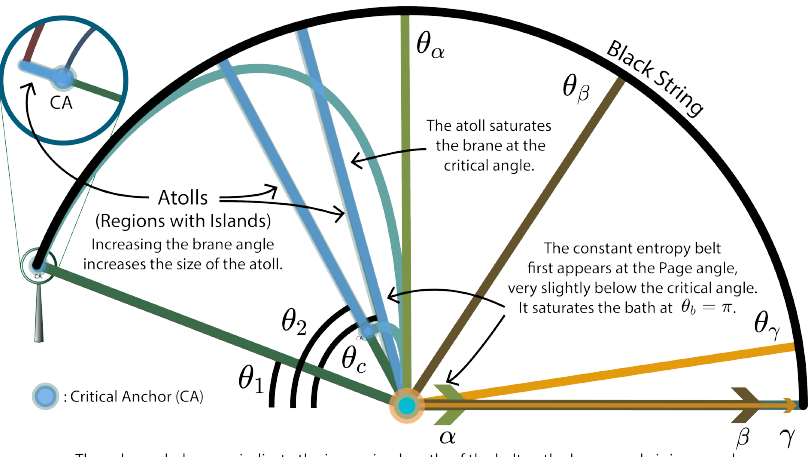
Figure 12 . When an RT surface anchors within the constant entropy belt on the bath, the island surfaces are dominant on the initial time slice and the entanglement entropy is constant in time. Decreasing the brane tension ( d − 1) cos θ increases the width of the belt, indicated by the color-coded b arrows on the boundary which correspond to the vertical axis in figure 11. The belt first appears at the Page angle, slightly below the critical angle, and covers the entire region outside the boundary black hole horizon (at Γ = 1 ) in the limit where θ 1 . All angles are measured from the boundary, b → and the tensionless limit is achieved at θ = π/ 2 b